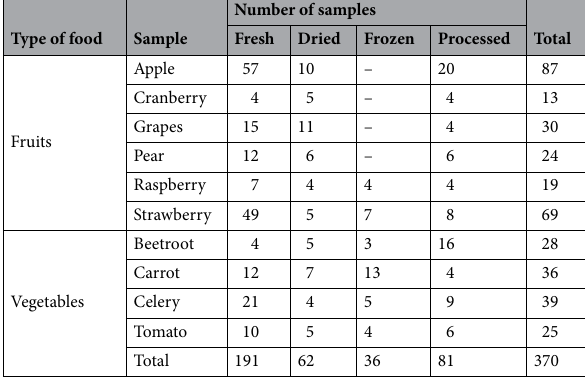
Table 1. The number of samples of particular types of vegetables and